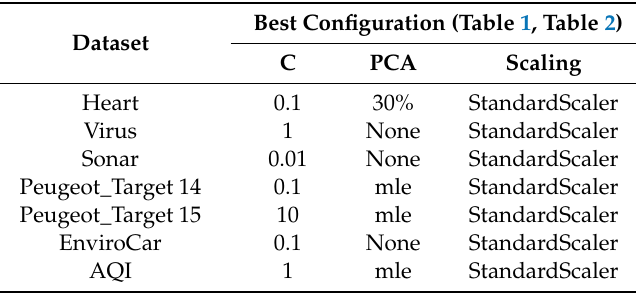
Table 9. Linear SVM corresponding configuration. Best Configuration (Table 1, Table 2)